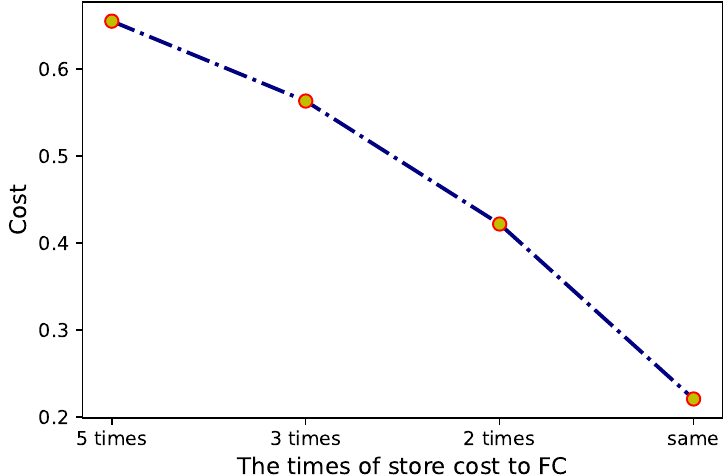
Figure 6. Impact of store cost on the average cost of order